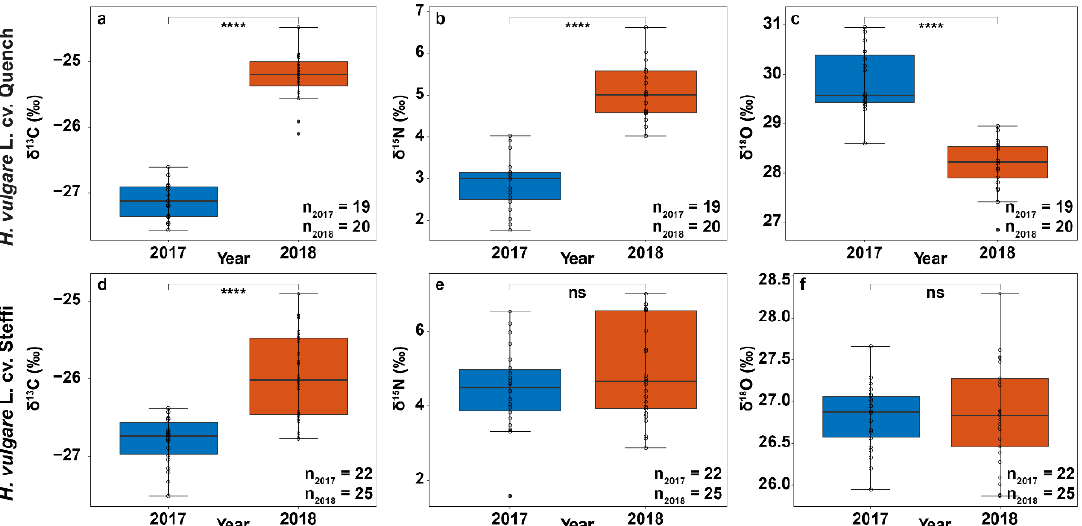
Figure 3. Natural stable isotope abundances of the analyzed spring barley samples. Box and whisker plot graphs with interquartile ranges, medians, error bars (non-outlier minimum and maximum) and results of the Mann–Whitney–Wilcoxon test on the isotopic values ( δ 13 C, δ 15 N, δ 18 O) of spring barley samples from the two varieties ( a – c ) Quench and ( d – f ) Steffi. Samples are grouped based on the crop years 2017 (blue) and 2018 (red). Highly significant differences ( p < 0.0001) are highlighted with four stars (****), while non-significant differences are marked with ‘ns’. Outliers are denoted as filled circles.